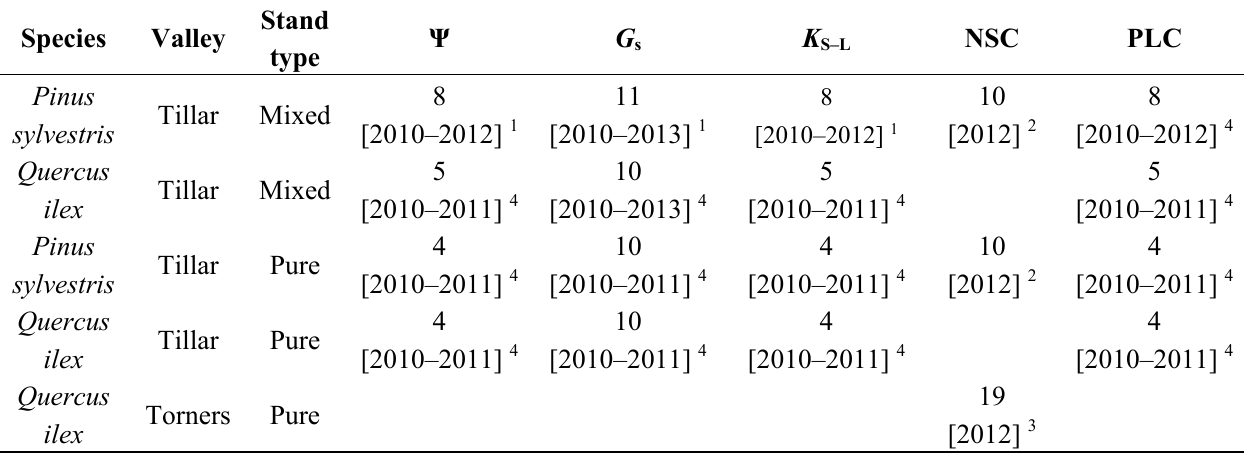
Table 2. Main variables reported in this